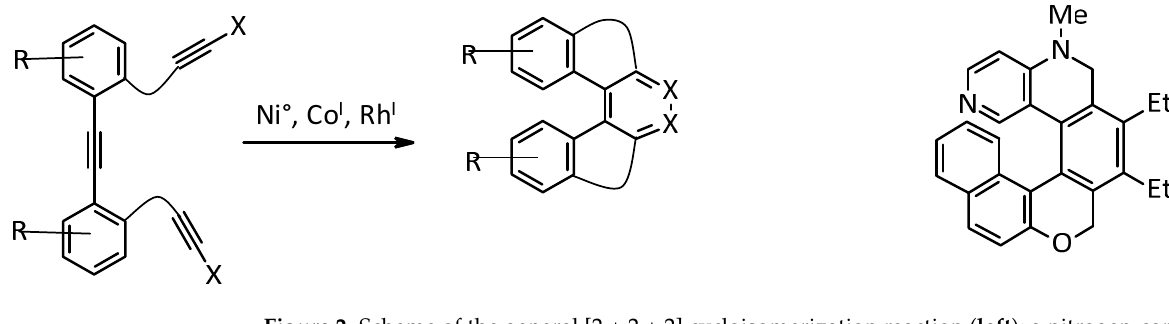
Figure 2. Scheme of the general [2 + 2 + 2] cycloisomerization reaction ( left ); a nitrogen-containing helicenoid structure obtained in this way (right).